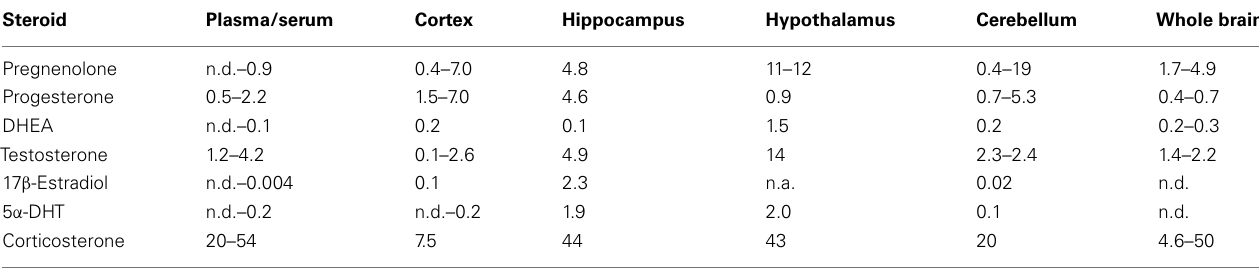
Table 2 | Selected measurements of endogenous steroid levels in adult male rat plasma or serum (ng/ml) and brain tissue (ng/g).